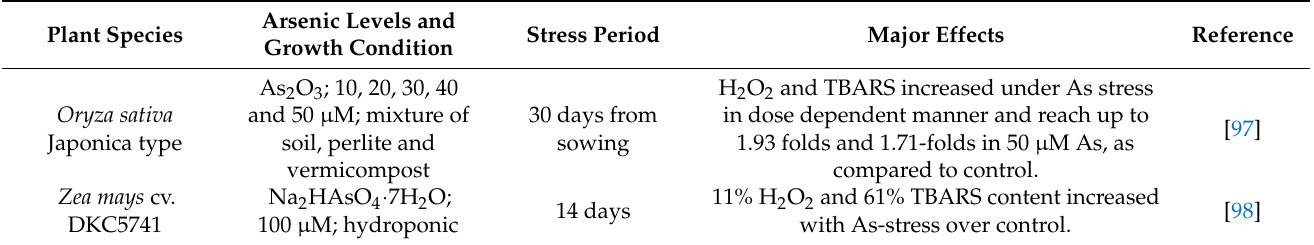
Table 1. Oxidative stress in different plant species under arsenic stress.